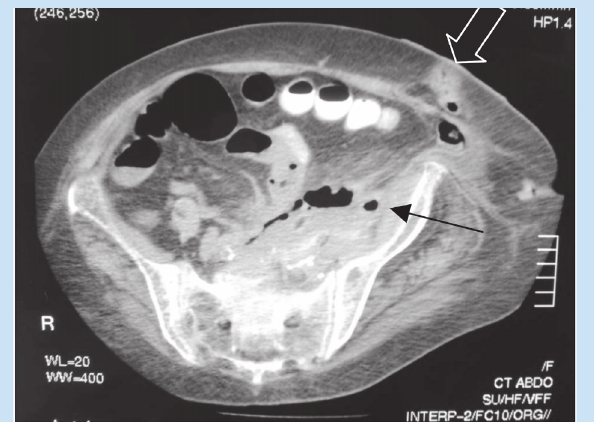
Figs. 1. CT scan showing the pelvic sidewall collection containing gas (arrow). Note left colostomy site (open arrow) blocking anterolateral access.